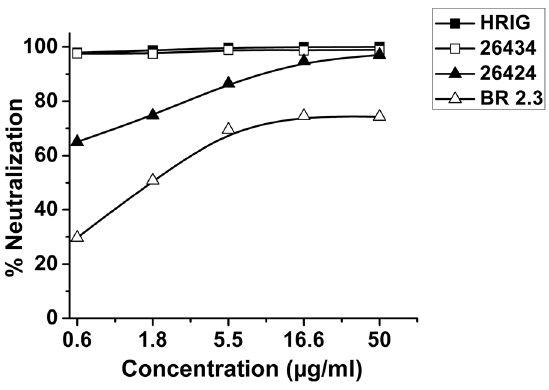
Figure 6. Percentage neutralization of 26424, 26434 and BR 2.3. Neutralization potencies have been calculated in percentage with reference to the decrease in RLUs of the antibody-treated samples as compared to negative control containing CVS-11 pseudotypes alone. Percentage neutralization of samples treated with 26424 and 26434 has been calculated against 6 6 10 5 RLUs input of CVS-11 pseudotypes (Figure 5A), while that for BR 2.3 (control sdAb in monomer format) was calculated against 7 6 10 3 RLUs of pseudovirus input (Figure 5B). HRIG was used as the positive control at similar concentrations of the test samples in all in vitro neutralization assays.